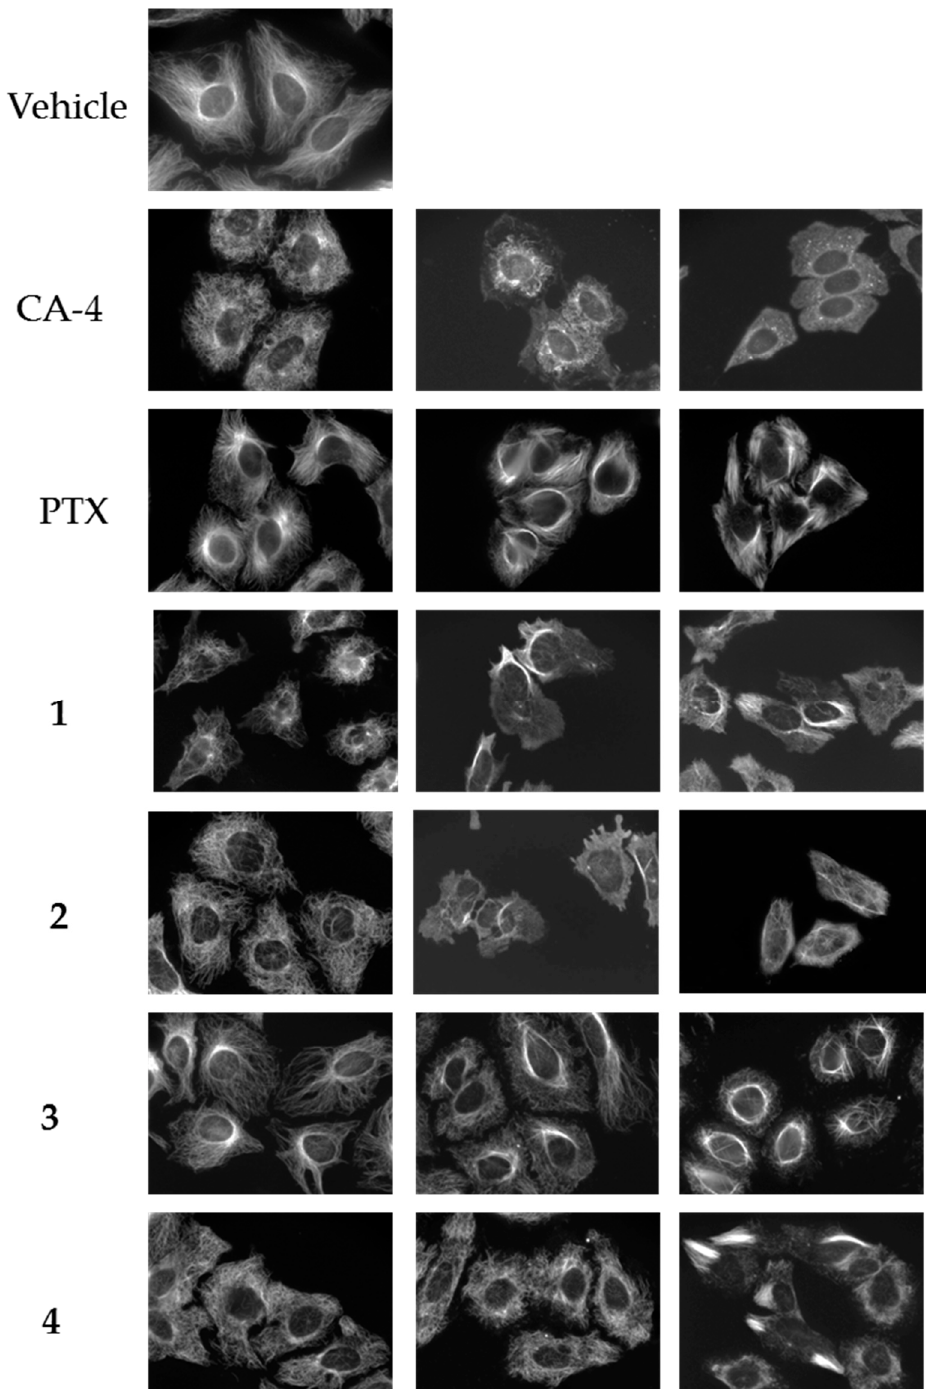
Figure 2. Concentration-dependent effects of the Janus compounds on cellular microtubules. HeLa cells were treated for 18 h with a range of concentrations of the microtubule destabilizer CA-4 (5, 7.5, and 15 nM), the microtubule stabilizer paclitaxel (PTX) (0.1, 0.5, and 1 μ M) or compounds 1 – 4 : 1 (30, 50, and 60 μ M); 2 (25, 60, and 75 μ M); 3 (10, 20, and 30 μ M); and 4 (20, 30, and 35 μ M). Microtubules were visualized by indirect immunofluorescence.